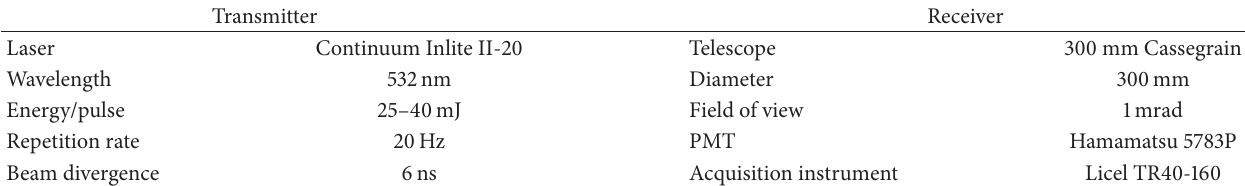
Table 1: Specification of the depolarization lidar system at Wuhan